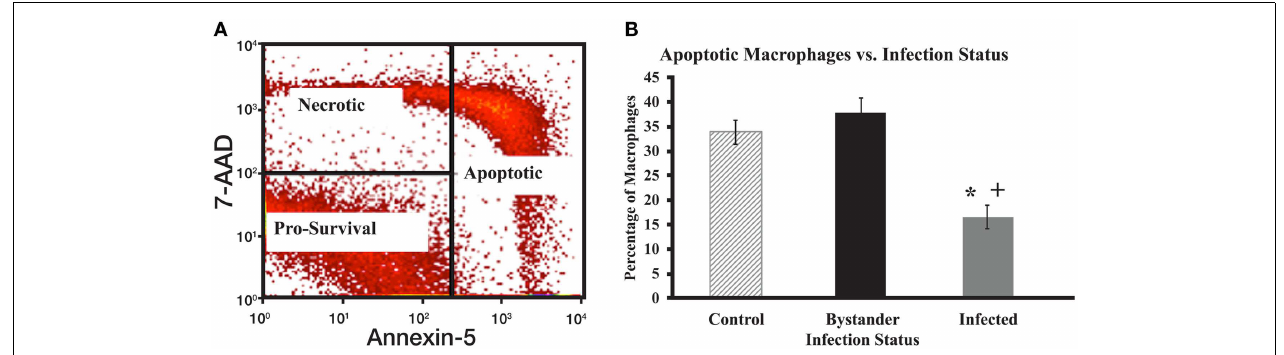
with little staining for either 7-AAD or AnnexinV were considered pro-survival (lower left quadrant). (B) The percentage of total apoptotic macrophages was determined by flow cytometry as described for (A) .The bars represent mean results obtained from MDM cultures isolated from six individual healthy Holstein cattle. Error bars represent Standard Error of the Mean (SEM) between the six biological replicates. A “ + ” indicates significantly different from control, uninfected cells at p < 0.05 and a “*” indicates significantly different from the bystander macrophage populations at p <